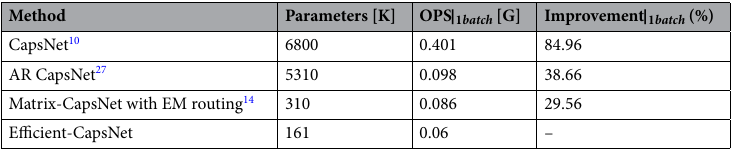
Table 1. Comparison of the computational cost in terms of necessary operations between Efficient-CapsNet and other similar methodologies present in literature. Efficient-CapsNet, besides having a reduced number of trainable parameters, is much more efficient.